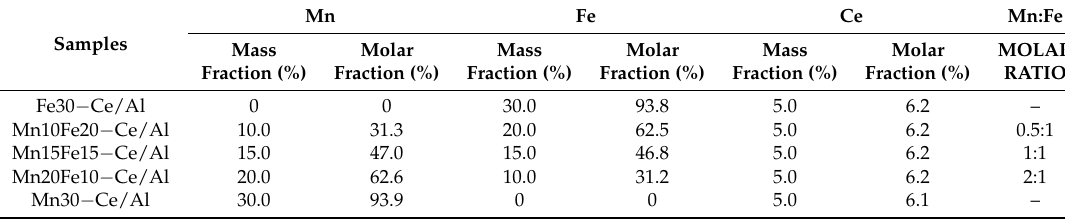
Table 5. Contents of Ce, Fe and Mn on Mn − Fe − Ce − O x / γ -Al 2 O 3